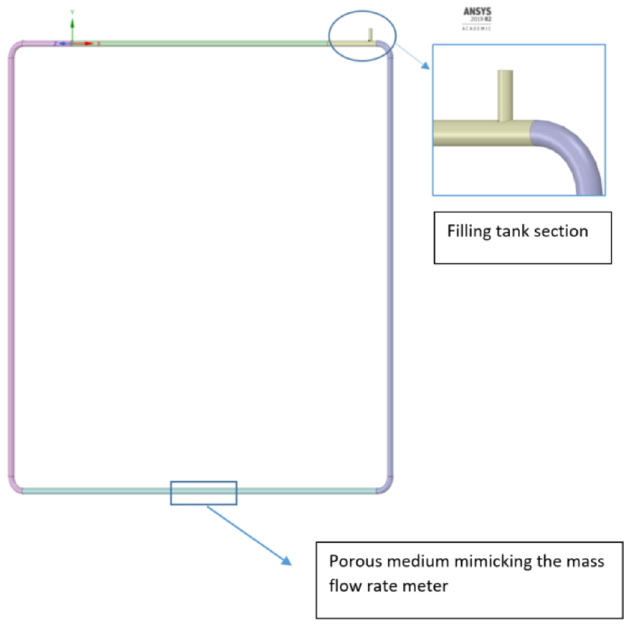
Fig. 4. CFD model of DYNASTY.